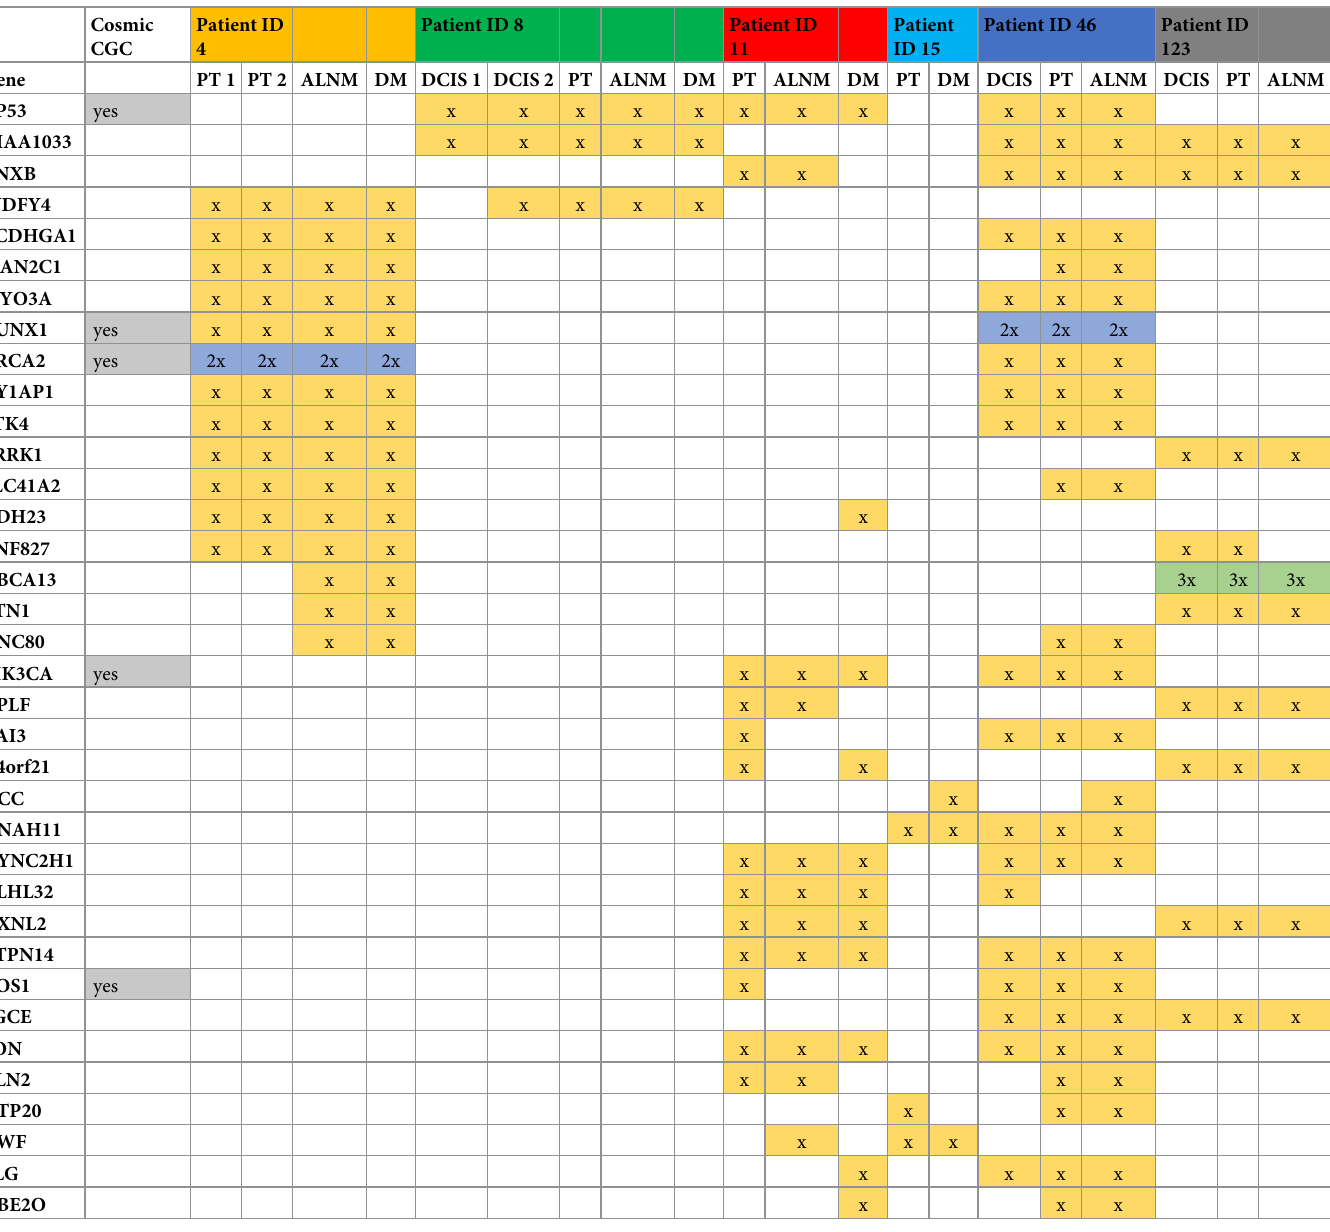
Table 5. Recurrently mutated genes across